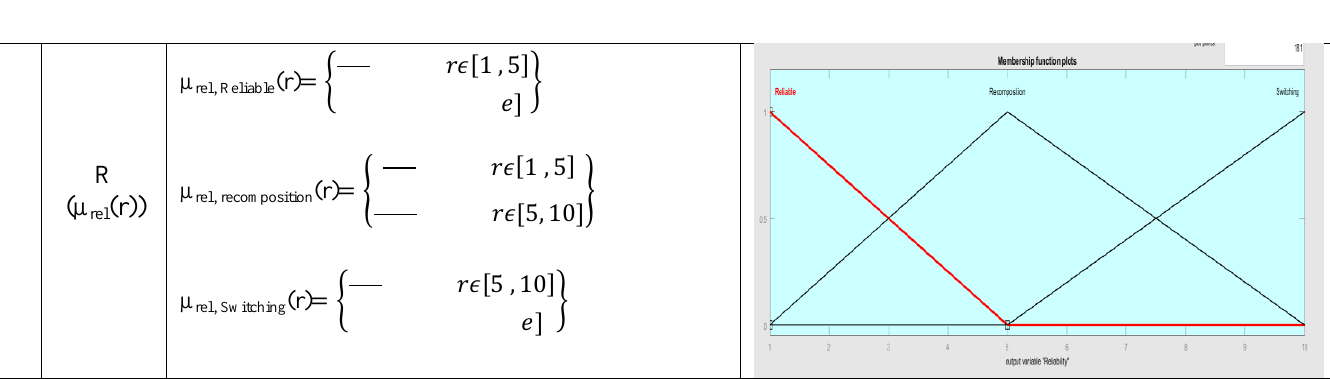
Table 8. Mathematical & Graphical MF of AFIS Input/output